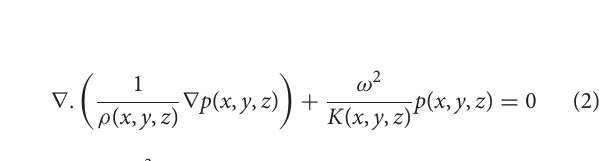
FIGURE 2 | Dispersion diagram for a periodic array (pitch d spherical rigid inclusions ( R pressure waves in air, vs. the wavenumber vector k along the edges of Ŵ XMU